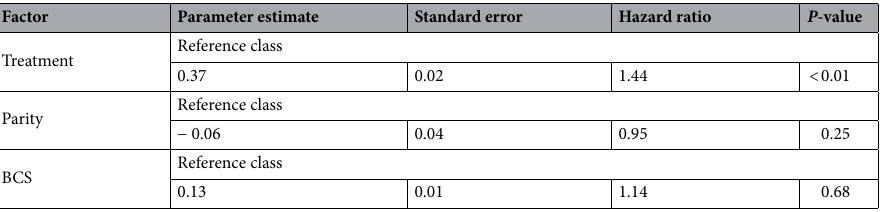
Table 2. Effects of treatment on the likelihood of pregnancy in dairy cows with and without beta-carotene. Parity and body condition score (BCS) were included as covariate variables. Days in milk and sires were also included in the model as stratified variables.